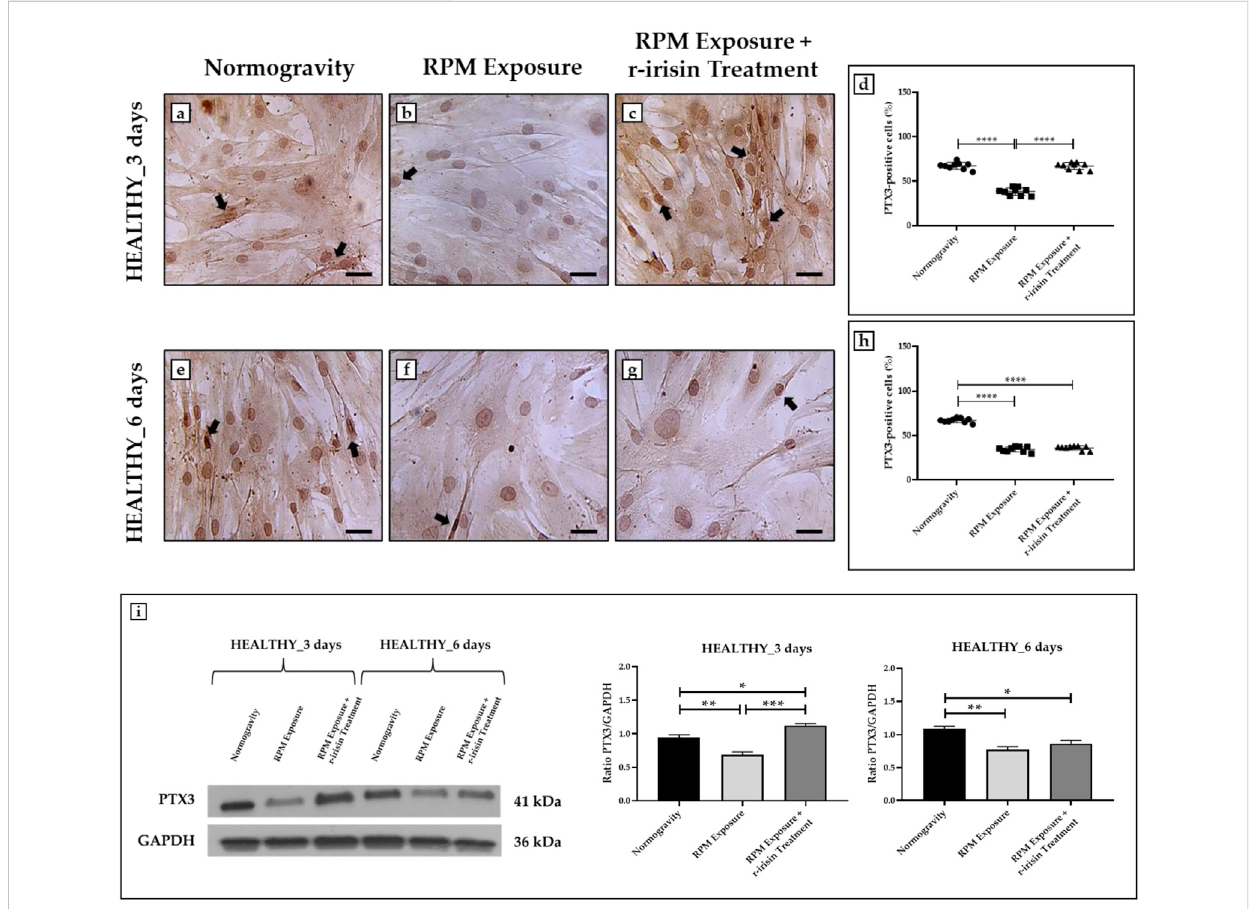
FIGURE 3 Effects of random positioning machine (RPM) exposure on the mineralization process in primary osteoblast cultures derived from healthy (HEALTHY) subjects. (a – h) Immunocytochemical analysis for PTX3: (a – d) signi fi cant increase in PTX3 expression (arrows) in cells exposed to 3 days of RPM and treated with r-irisin; (e – h) PTX3 expression (arrows) was not preserved by r-irisin treatment after 6 days of RPM exposure. (i) Western blotting analysis for PTX3: increased PTX3 expression in r-irisin-treated cells (3 days); PTX3 expression was not preserved by r-irisin treatment in cells exposed to 6 days of RPM. Images were magni fi ed × 20, scale bar represents 50 μ m.